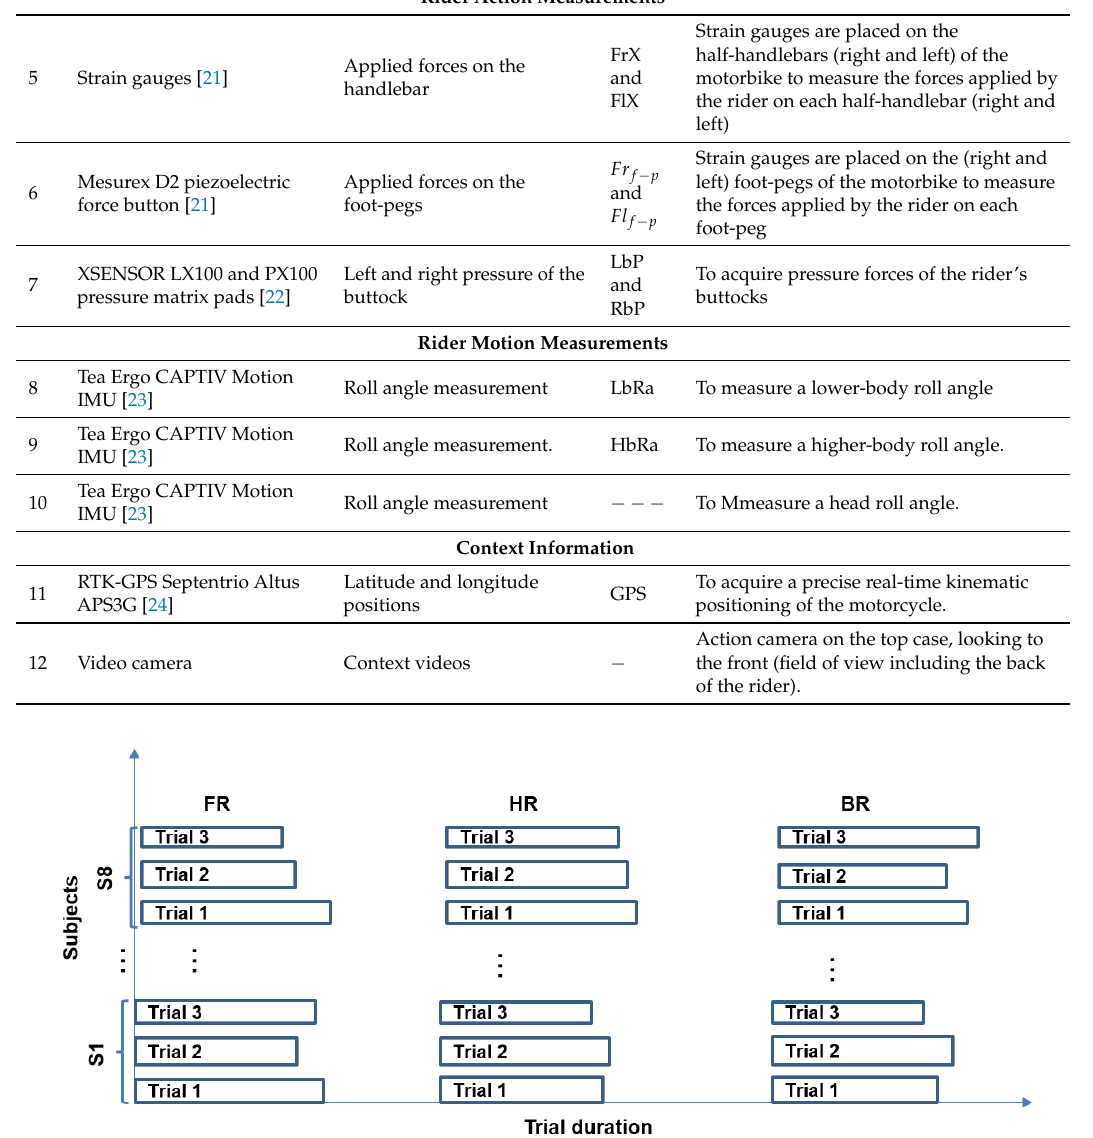
Figure 2. Three riding trials by eight subjects with each riding instruction: FR, HR, and